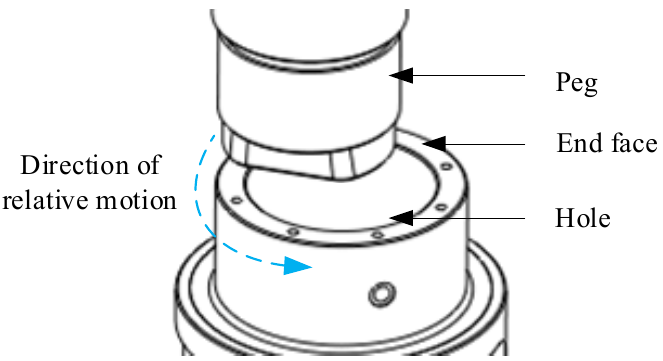
Figure 1. Schematic diagram of peg-in-hole.